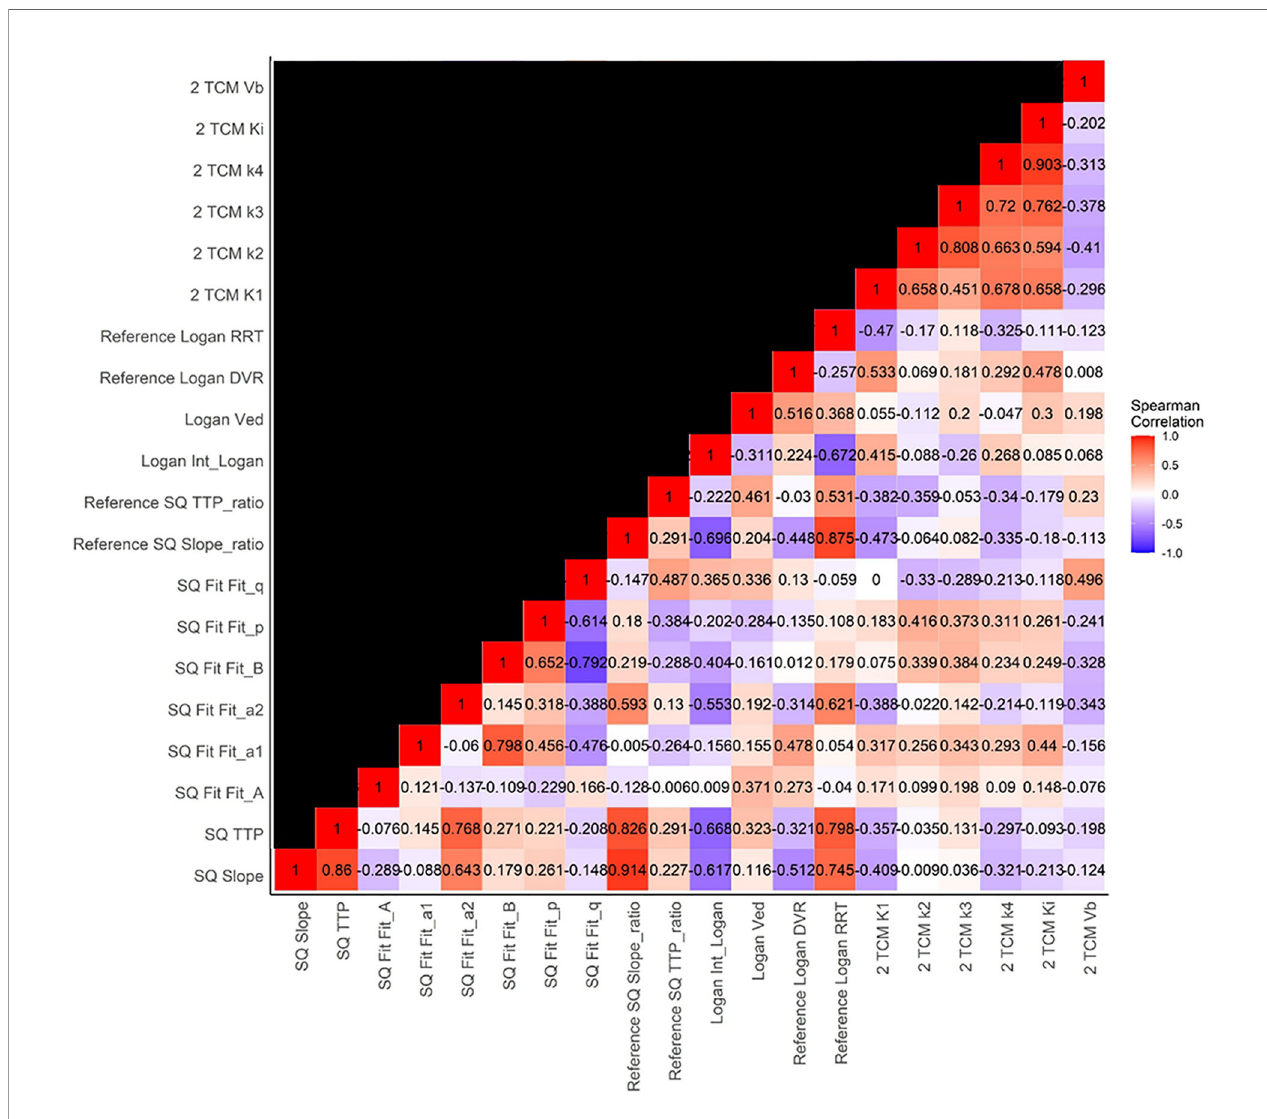
FIGURE 3 | Heatmap of Spearman ’ s correlation coef fi cients for the individual parameters of each of the